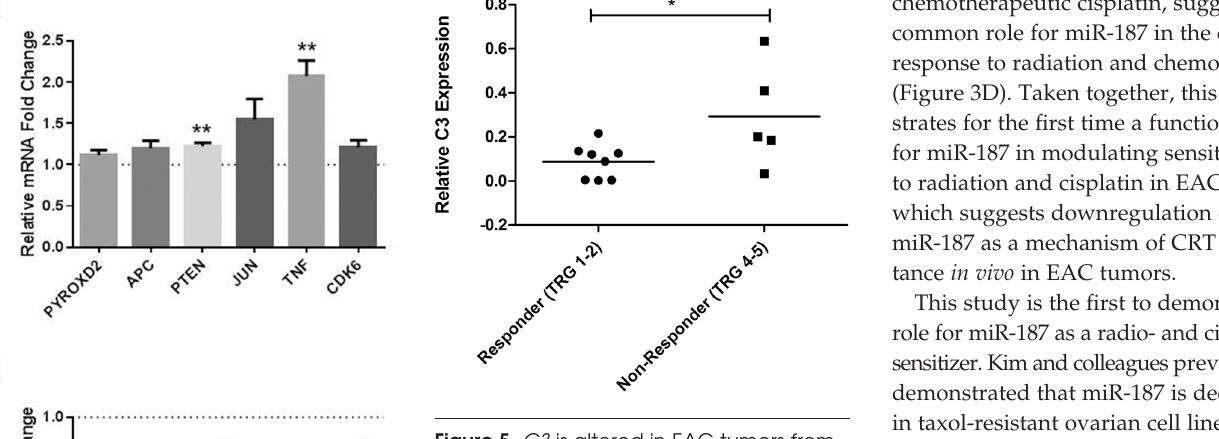
Figure 5. C3 is altered in EAC tumors from nonresponders. C3 mRNA expression was assessed in pretreatment diagnostic tumor biopsies from EAC patients ( n = 13) by qPCR. C3 expression was significantly higher in nonresponders (TRG 4 and 5) when compared with responders (TRG 1 and 2). Statistical analysis was performed using an unpaired, two-tailed Student t test, * p < 0.05.